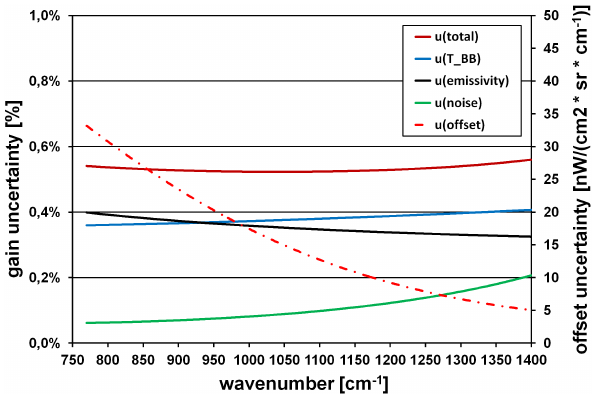
Fig. 2. Radiance uncertainty (gain and offset) according to requirements.